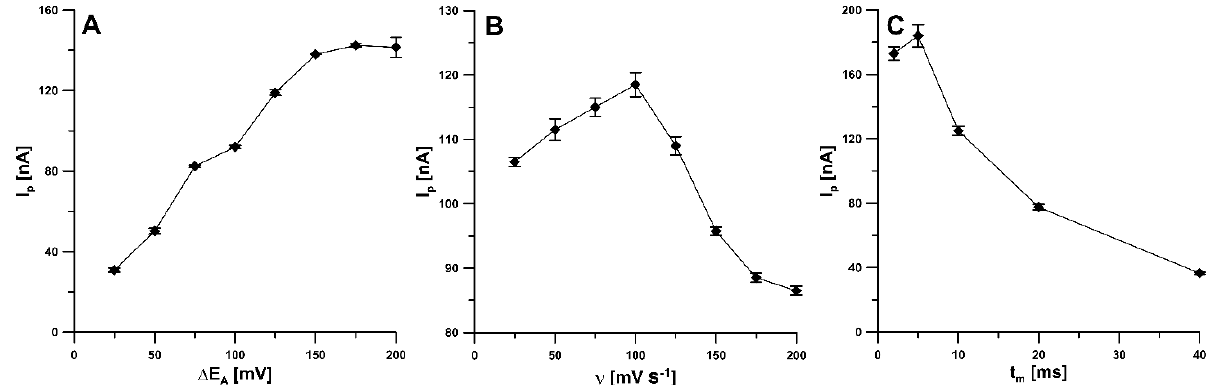
Figure 7. Effect of ∆ E A ( A ), ν ( B ) and t m ( C ) on analytical response of 0.5 nM RIF. The DPAdSV parameters: E acc of − 0.45 V and t acc of 120 s.